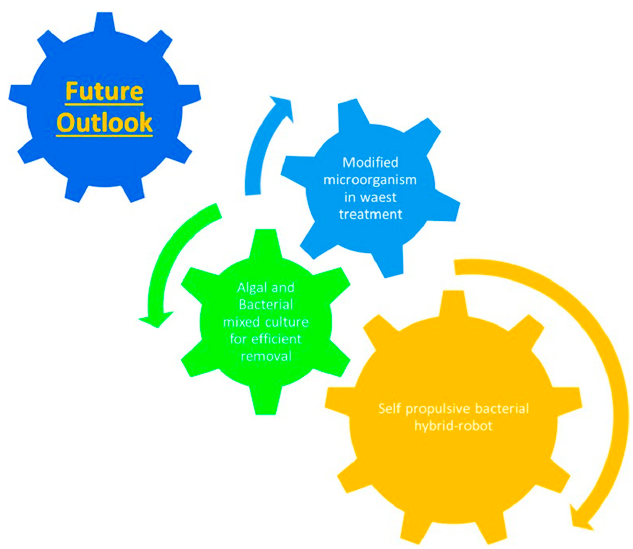
Figure 12. Future prospects of microbial based water treatment strategies.